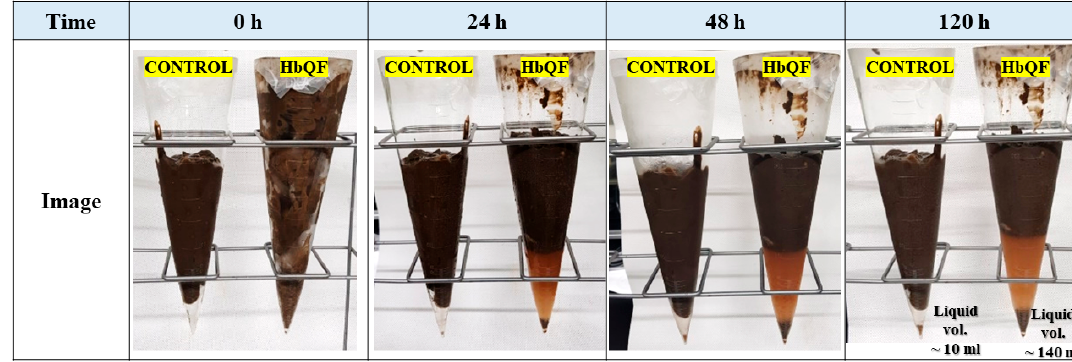
Figure 13. Images of sludge samples according to the time thawed in a refrigerator.